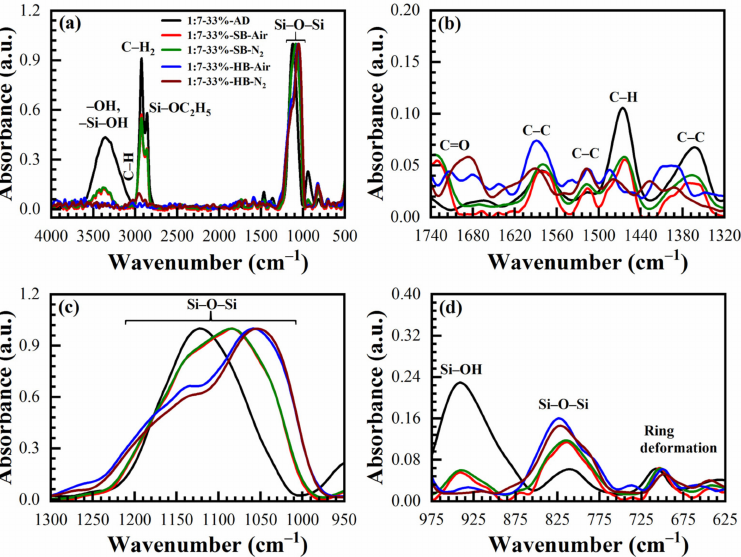
Figure 8. FTIR spectra of benzene-bridged (135TTEB:13BTEB = 1:7 material) organosilicate films with 33 wt% porogen loading; where ( a ) is the full FTIR spectra and ( b – d ) are the parts of the full FTIR spectra. The films are as-deposited (AD), soft baked (SB) at 150 ◦ C in the air (SB-Air) and N 2 (SB-N 2 ) for 30 min, hard baked (HB) at 400 ◦ C in the air for 30 min (HB-Air) and in N 2 for 60 min (HB-N 2